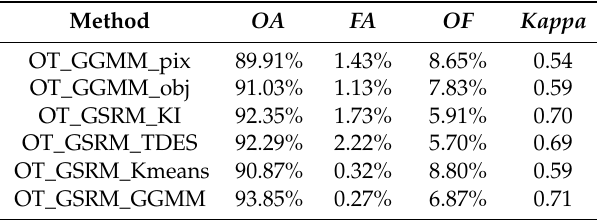
Table 3. Performance evaluation over LiangZi Lake from 2011, 2015, and 2016.